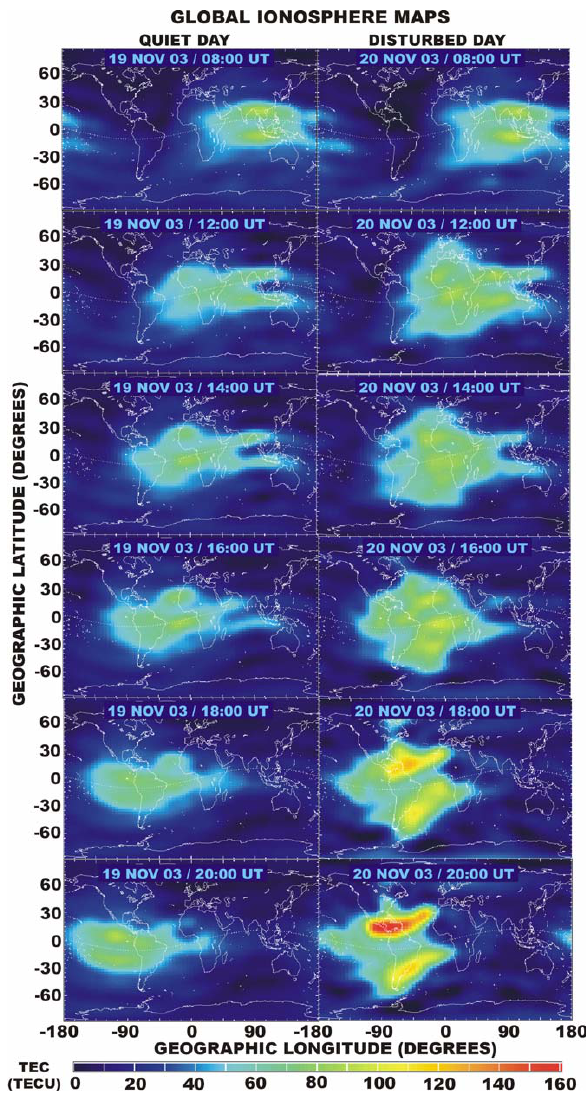
FIGURE 9 Fig. 9. “Global Ionospheric Maps” using the IGS GPS stations ob- served on 19 November (quiet) and 20 November (geomagnetically disturbed) 2003 between 10:00 UT and 20:00 UT (every